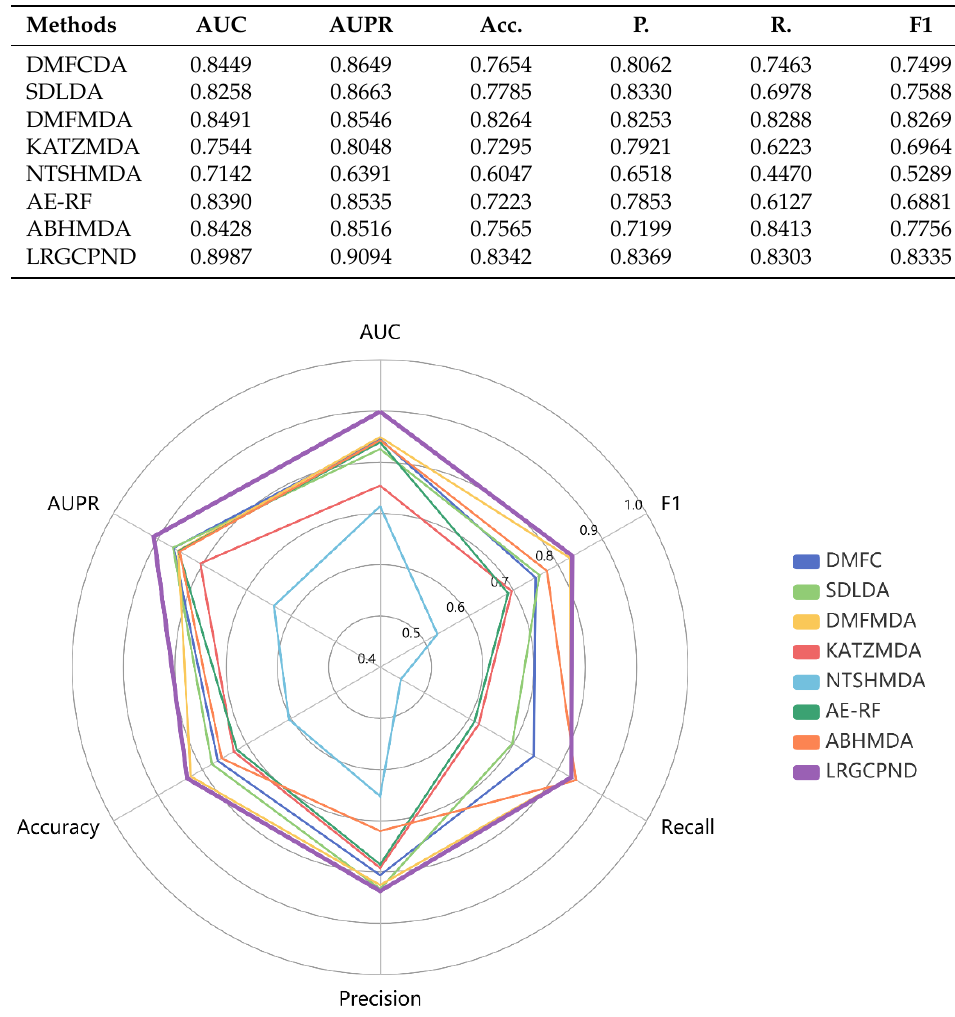
Figure 6. Performance comparison using multiple metrics in five-fold CV.